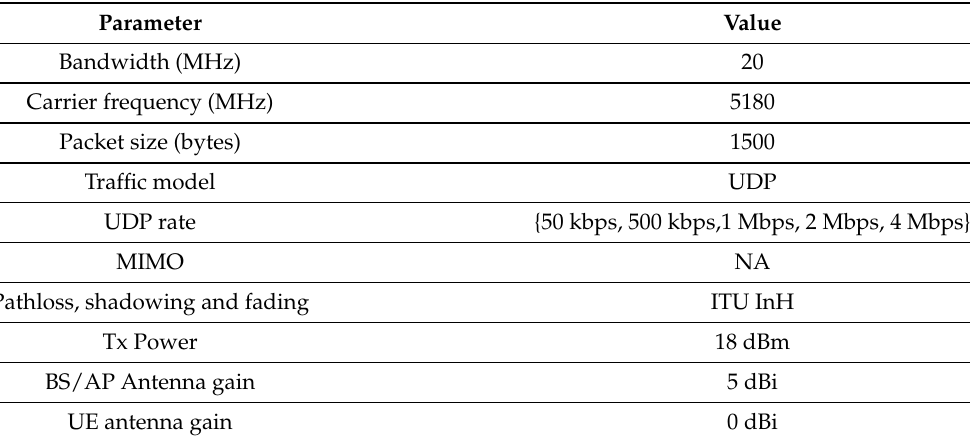
Table 3. Common parameters used to model co-located IEEE802.11n and LTE networks